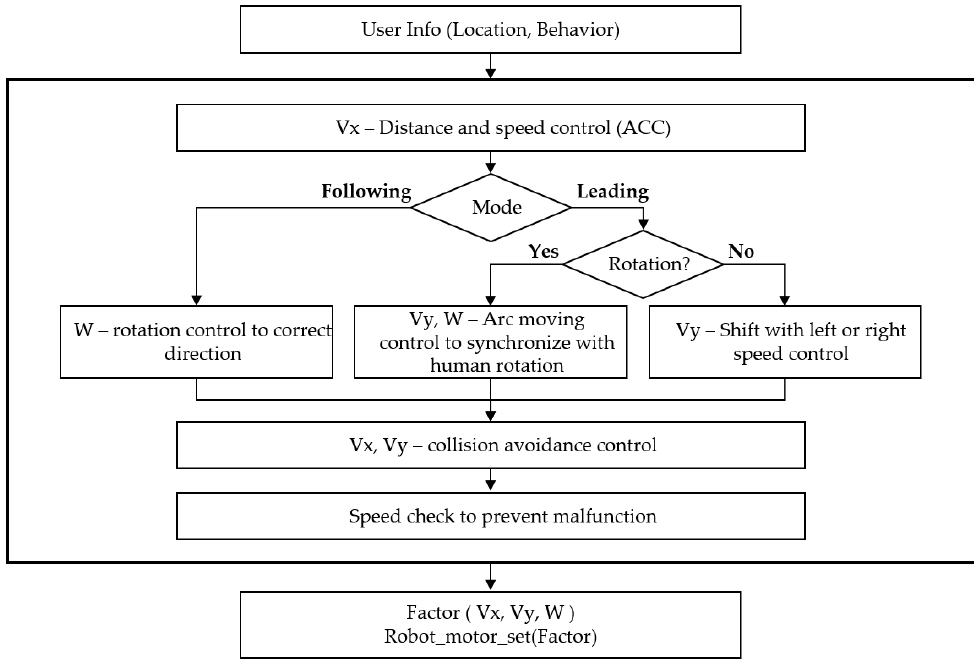
Figure 13. Control system of a mobile robot when following or leading a human.